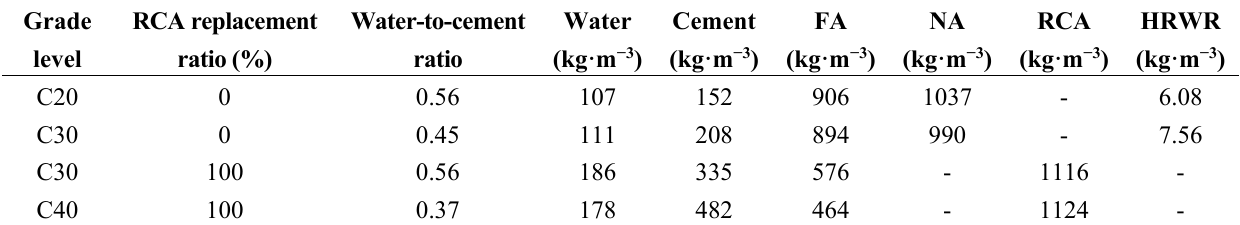
Table 1. Dry-weight proportions of normal and recycled coarse aggregate (RCA) concrete mixes. FA: fine natural aggregates; NA: coarse natural aggregates; and HRWR: high range water reducer.